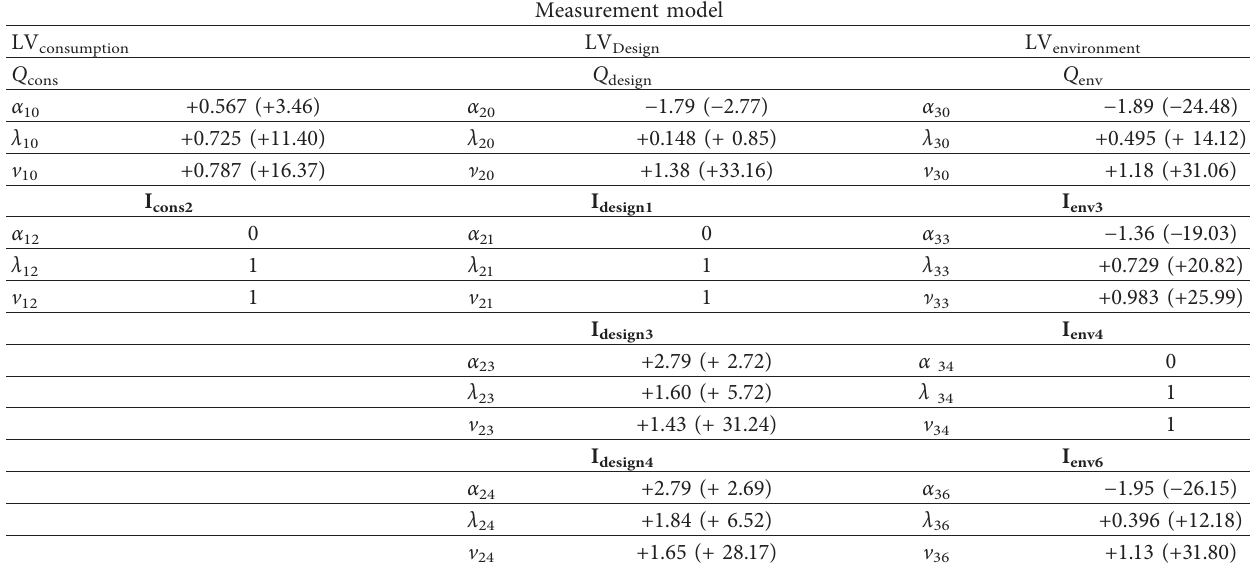
Table 9: Estimation results for the measurement models of